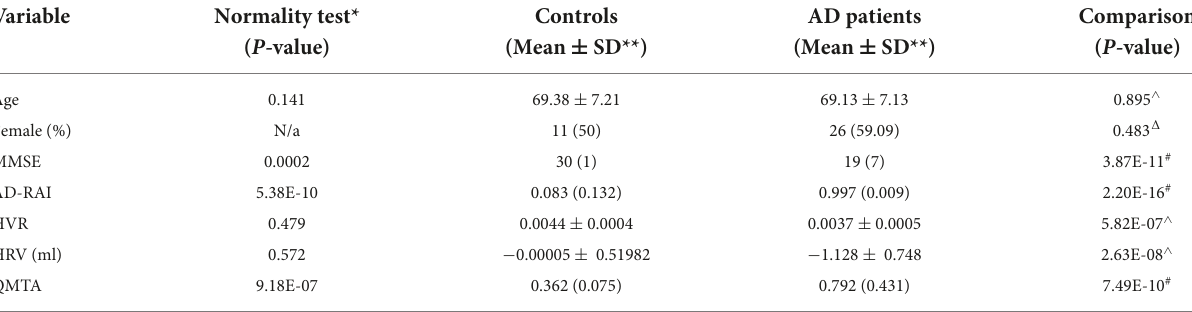
TABLE 1 Comparisons of age, sex, MMSE, AD-RAI, HVR, HRV, and QMTA at baseline across groups. Variable